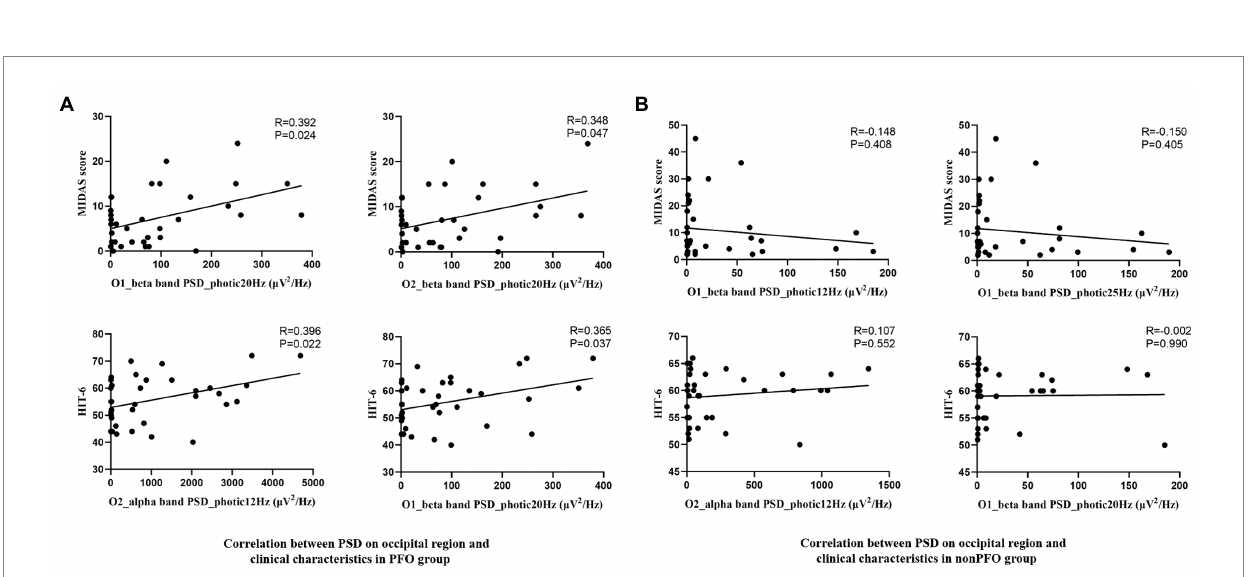
FIGURE 4 Scatterplot of the beta band PSD of the occipital region during photic stimulation at 20 Hz and the MIDAS score, and alpha band PSD during photic stimulation at 12 Hz, beta band PSD during photic stimulation at 20 Hz and HIT6 score in PFO + ( n = 35) and PFO– ( n = 35) group. Positive correlation was found in PFO + group (A) , but not in PFO – group (B)